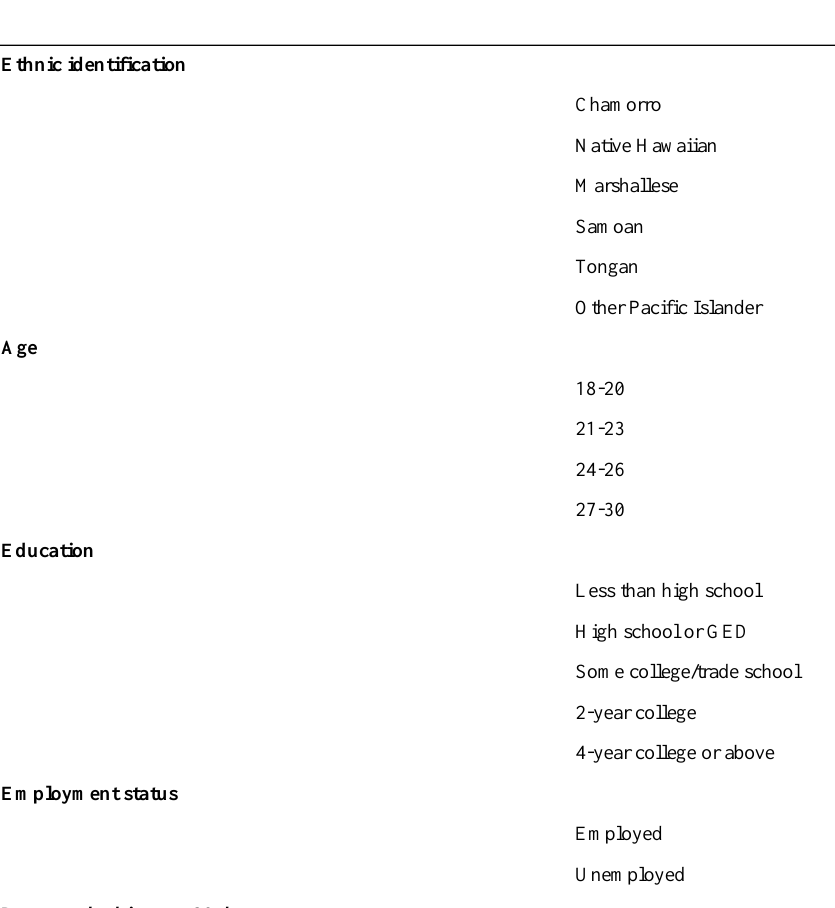
Table 1. Descriptive statistics for demographics and tobacco use from 20 participants.